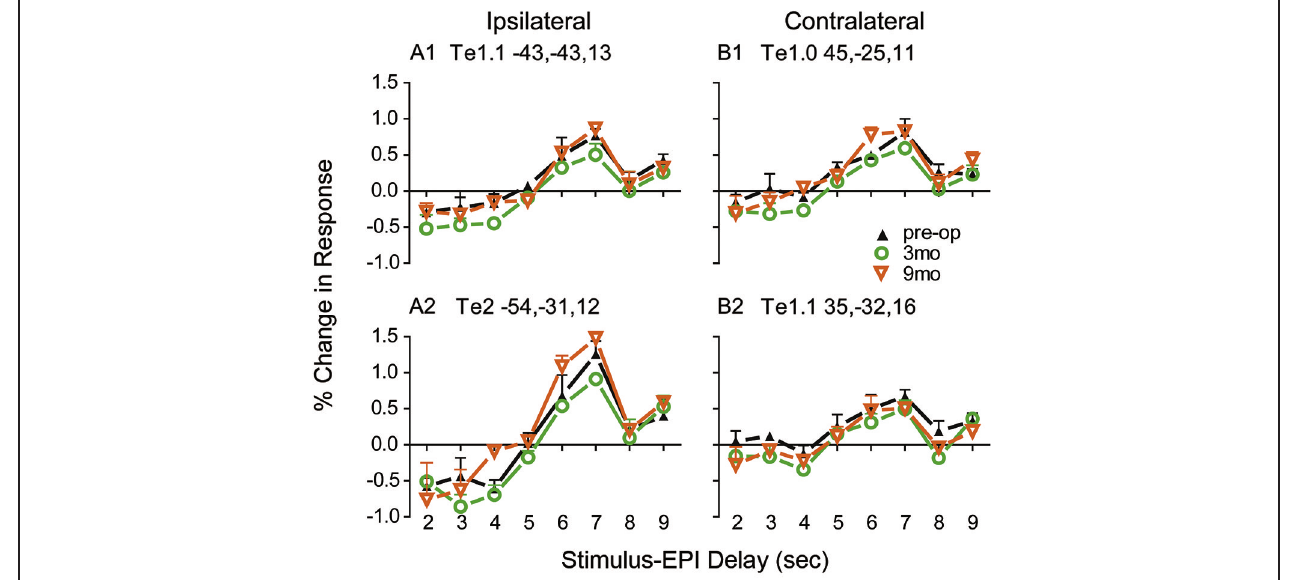
FIGURE 8 | Reconstructed BOLD response time courses based on RSS delays of 2–9 seconds during silent periods immediately before the next volume acquisition. Plotted at each stimulus-EPI delay is the mean and standard error for the per cent change in BOLD amplitude over baseline from trials with no stimulation. BOLD % change response amplitudes extracted